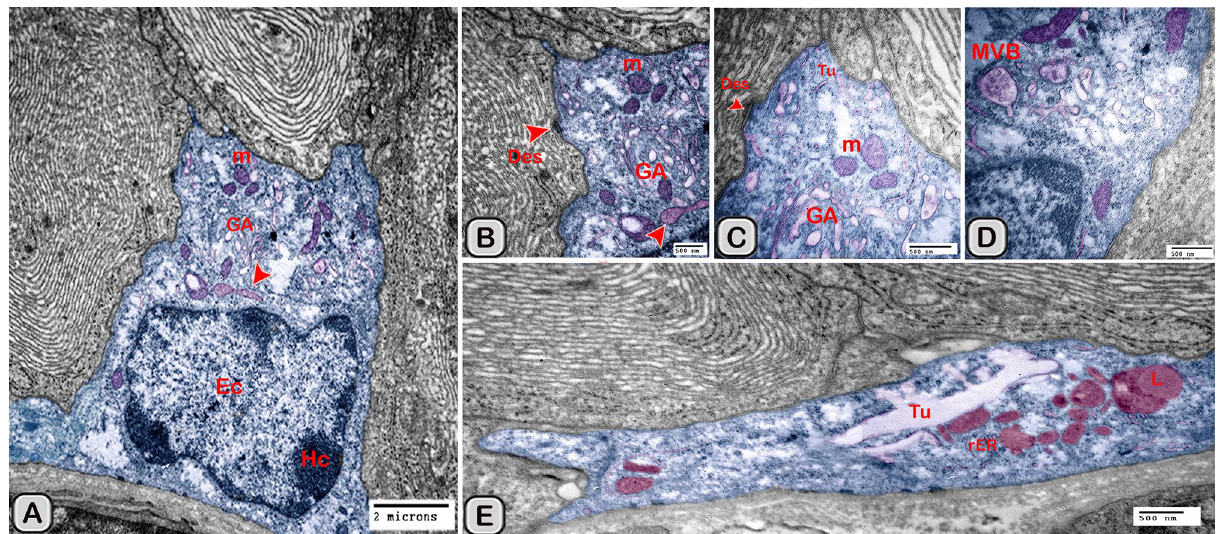
Figure 13. Digitally colored transmission electron microscope images of the activated DCs in the melatonin treated group. (A) General view of an active polyhedral dendritic cell with an abundant cell organelles and euchromatic nucleus (Ec). (B–D) Higher magnification showing abundant mitochondria (m) and well developed Golgi apparatus (GA). (B–E) Birbeck granules (red arrowheads), multivesicular bodies (MVB), tubules (Tu) and phagolysosomes (L) were observed. Desmosomal cell junction with the neighboring cell (red arrowhead, Des) was